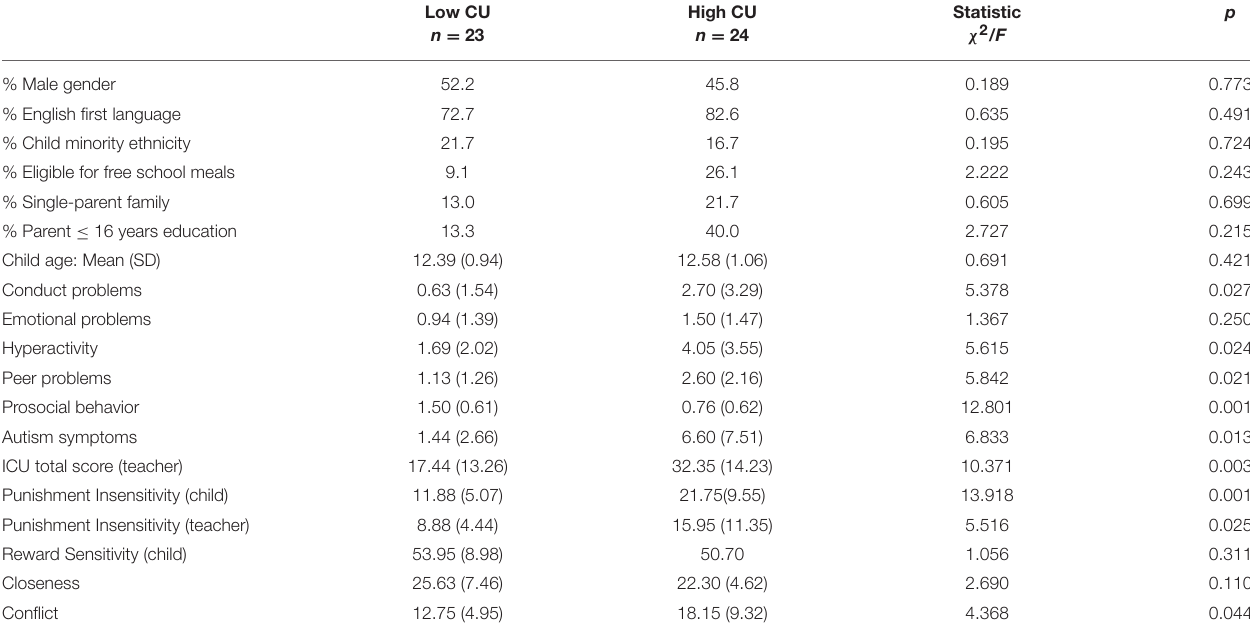
TABLE 2 | Demographic and adjustment data for children high vs. low in self-reported CU